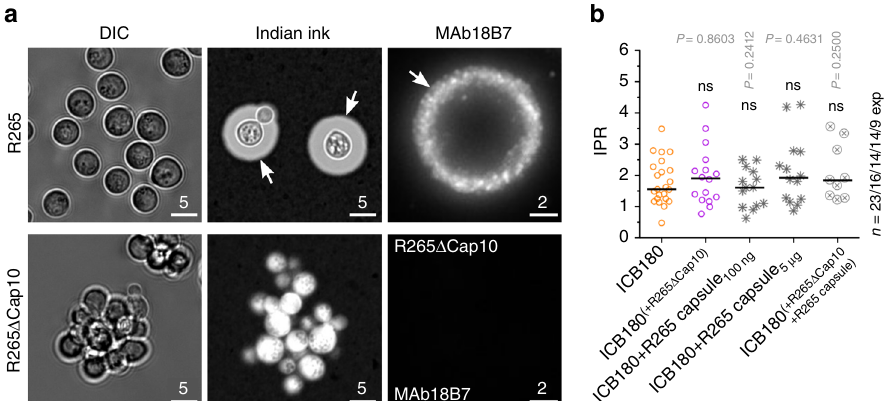
Fig. 2 Capsular material is necessary but not suf fi cient to increase the IPR of non-outbreak cryptococci. a Differential interference contrast (DIC; left), India Ink (middle) and immunostained (MAb 18B7; right) images of wild-type R265 (top) and acapsular R265 Δ Cap10 (bottom), indicating the presence of the characteristic thick polysaccharide capsule in the wild-type (arrows). Note the lack of any visible capsule in the acapsular mutant. Bars: 5 and 2 μ m. b IPR of a non-virulent ICB180 strain is not altered by the presence of acapsular R265 Δ Cap10 in the transwell assay (ICB180 ( + R265 Δ Cap10) ), nor by the addition of capsular material isolated from R265 (ICB180 + R265 capsule 100ng ; ICB180 + R265 capsule 5 μ g ). An addition into the transwell of acapsular R265 Δ Cap10 strain mixed with the capsular material isolated from R265 also did not change the IPR of ICB180 (ICB180 ( + R265 Δ Cap10 + R265 capsule) ). Data are presented as scattered dot plots with lines representing their medians. Individual Wilcoxon matched-pairs signed rank test presented as P values above each dot plot, where ns ( P > 0.05), not signi fi cantly different. Data are representative of results from at least nine independent experiments with 808 –